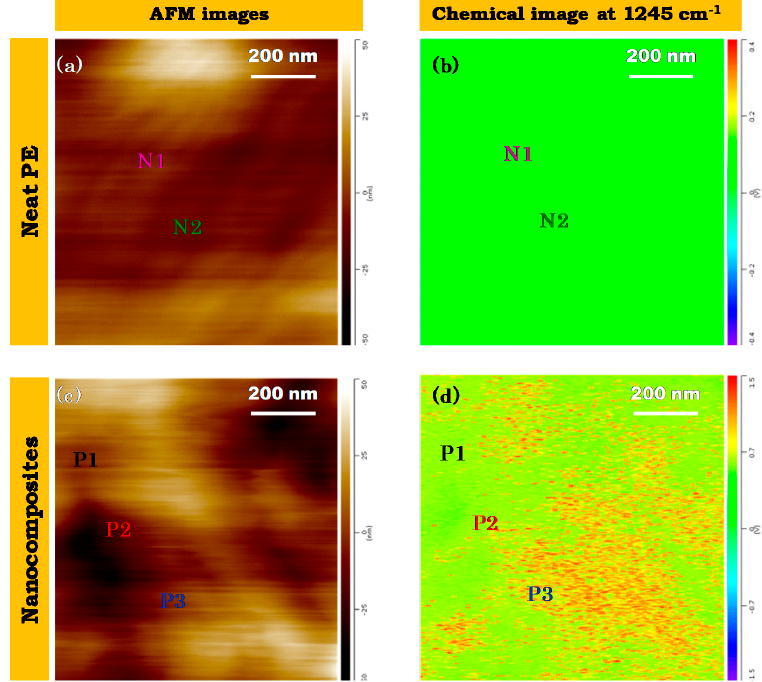
Figure 7. ( a ) high resolution AFM images of neat HDPE; ( b ) IR-mapping image of neat HDPE; ( c ) high resolution AFM images of HDPE/FeAg NPs nanocomposites; ( d ) IR mapping image of HDPE/FeAg NPs nanocomposites. The points N1, N2, P1, P2, P3 are points corresponding to the nano-spectra analysis described below in Figure 8. Film thickness was close to 500 nm, deposed on Si-wafer